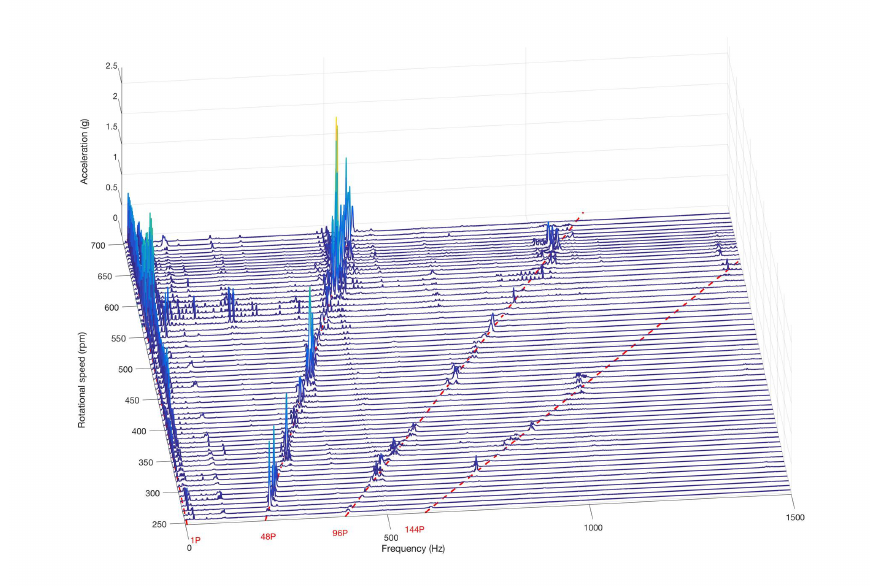
Figure 17. Waterfall of vibration of the tail fin in the Y